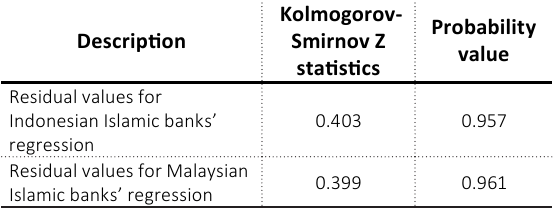
Table 6. Residual normality test results